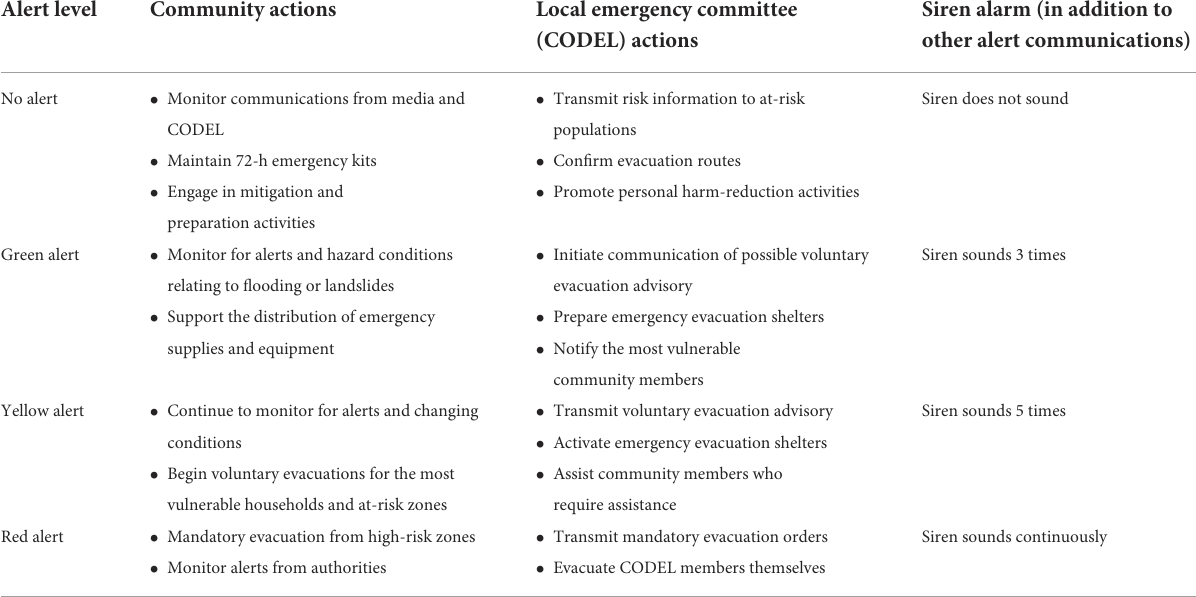
TABLE 1 The EWRS incorporates four alert levels, increasing in severity from No Alert to Red Alert, with corresponding actions for different stakeholders at the community level, institutional level, and first